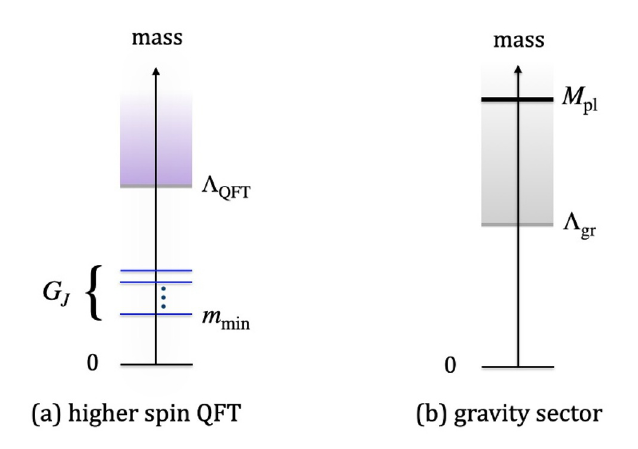
Figure 1 . Spectrum of particles with spin J ≥ 3 . Figure (a) represents a QFT that contains higher spin particles { G which are effectively elementary below the cut-off scale Λ J } such a theory cannot be coupled to gravity while preserving causality unless there are higher spin states in the gravity sector at Λ much below the Planck scale, Λ gr